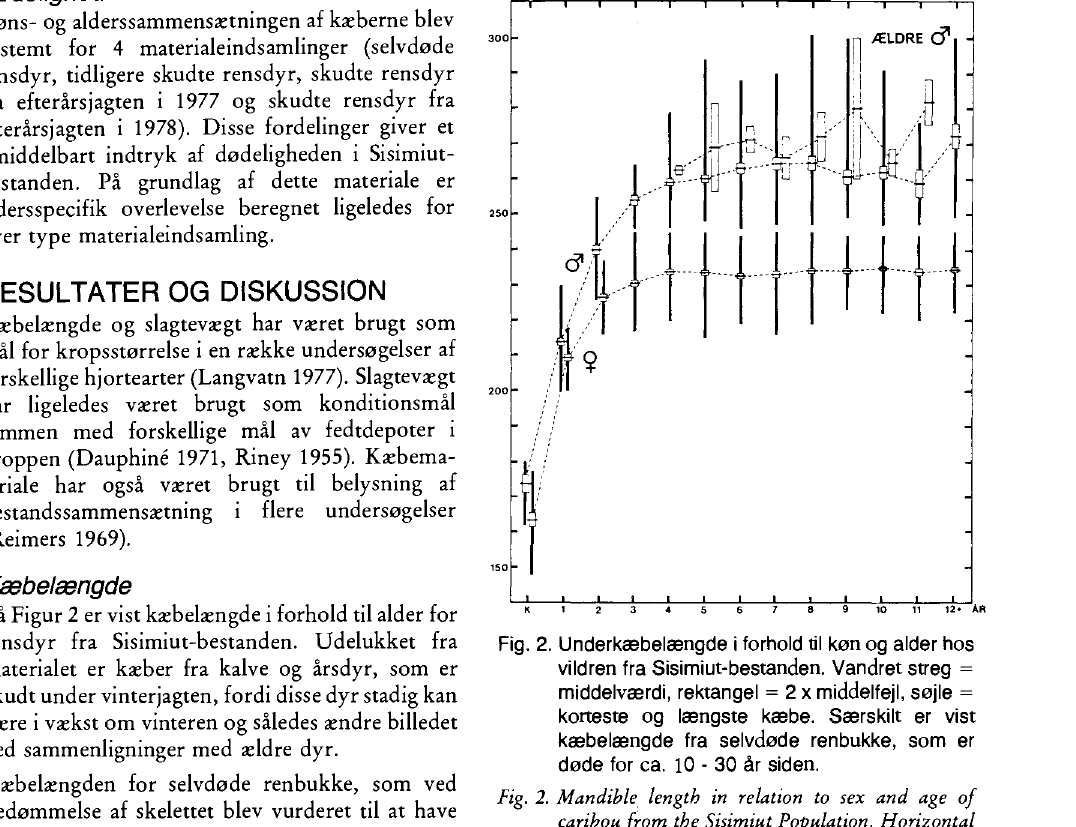
Fig. 2. Underkæbelængde i forhold til køn og alder hos vildren fra Sisimiut-bestanden. Vandret streg = middelværdi, rektangel = 2 x middelfejl, søjle = korteste og længste kæbe. Særskilt er vist kæbelængde fra selvdøde renbukke, som er døde for ca. 10 - 30 år siden. Fig. 2. Mandible length in relation to sex and age of caribou from the Sisimiut Population. Horizontal lines = mean, rectangle = 2 standard errors, bar = range. Mandible length from straved caribou bulls, which have died about 10 - 30 years ago, is shown